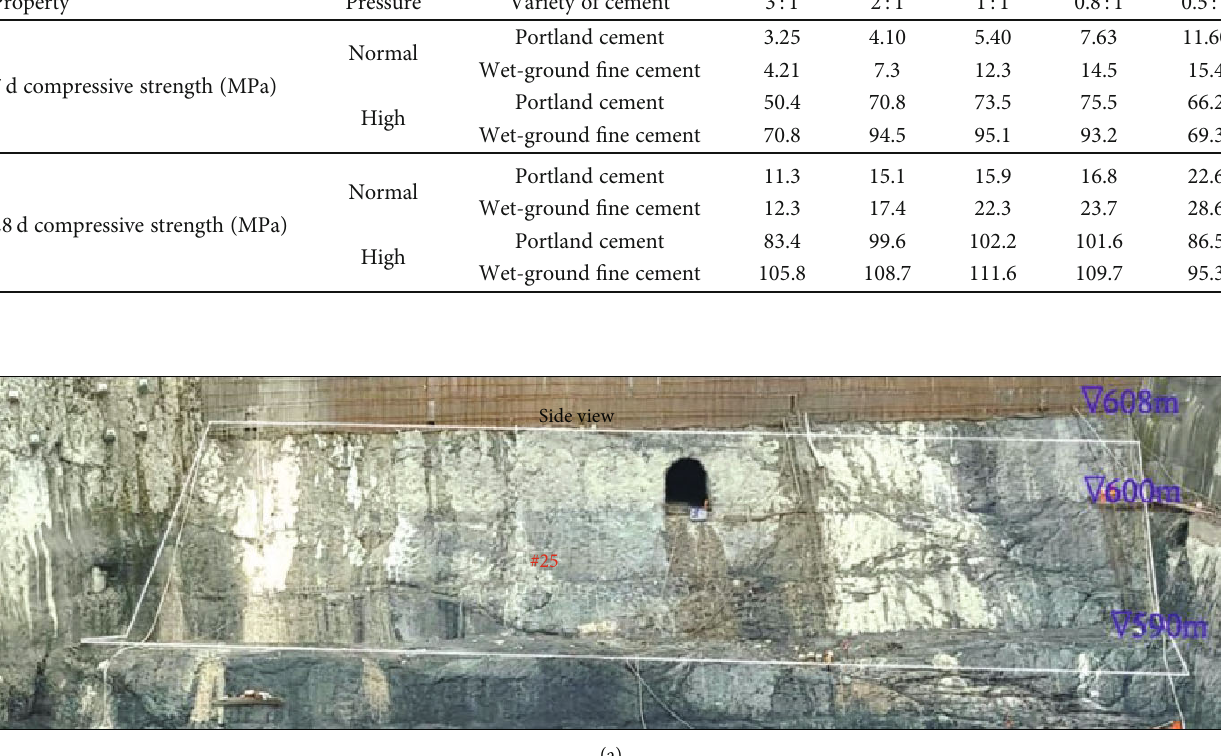
Table 5: Properties of the ordinary cement slurry and the wet-ground cement slurry under normal pressure and high pressure. Property